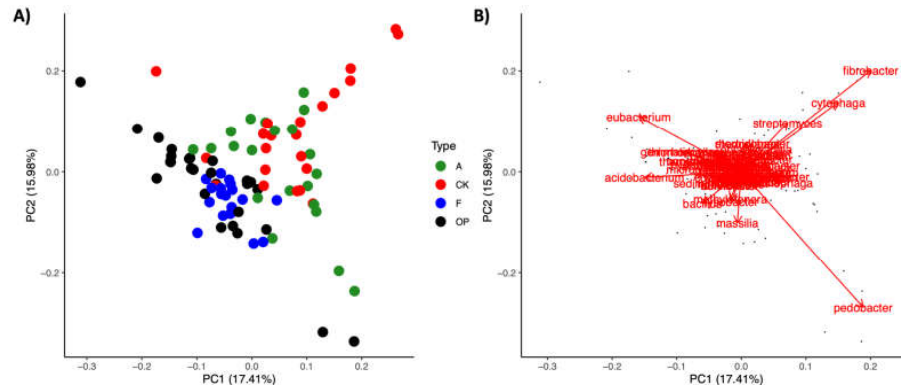
Figure 4. Principal components analysis of dune microhabitat (blowout (OP), A. breviligulata ( A ), C. kobomugi (CK), and foredune toe (F)) microbiomes based on percentage community composition at the genus level. All the samples collected in this study are shown based on their respective microhabitat ( A ) and with arrows representing the vectors of factor loadings ( B ). The percent variation explained by the PCs of the principal components analysis is indicated on the axes.